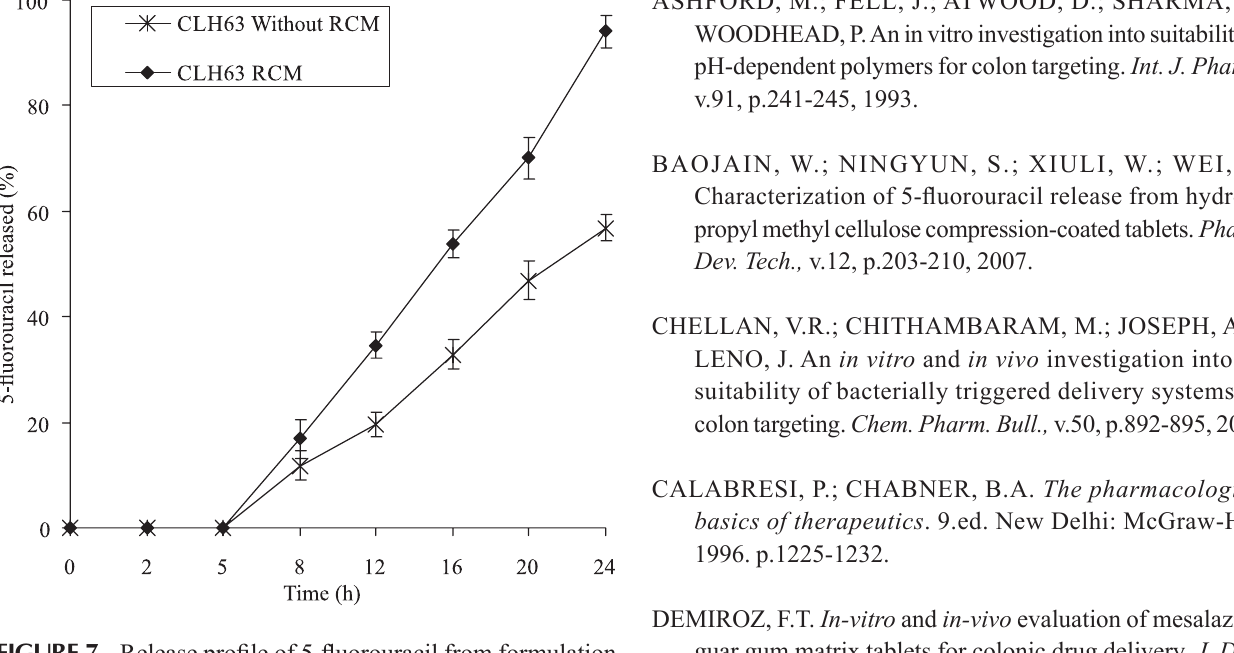
FIGURE 7 - Release profile of 5-fluorouracil from formulation CLH63 after storage at 40 o C/75% RH for 6